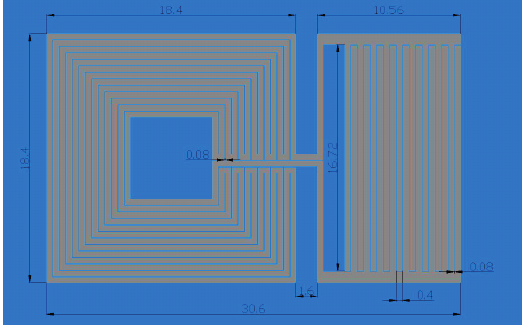
Figure 2. The dimensions of the LC